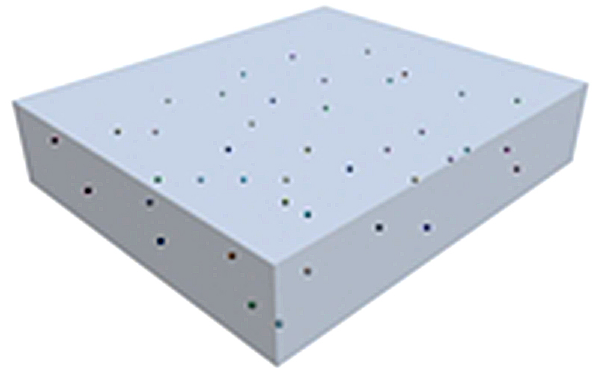
Figure 8. Multi-surface closed geometry containing point set.